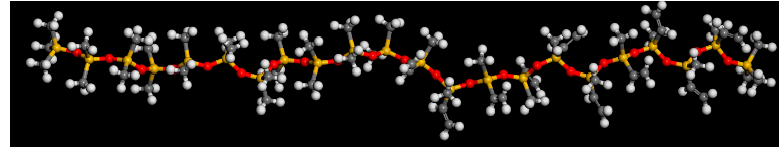
Figure 3. Optimized molecular structure.